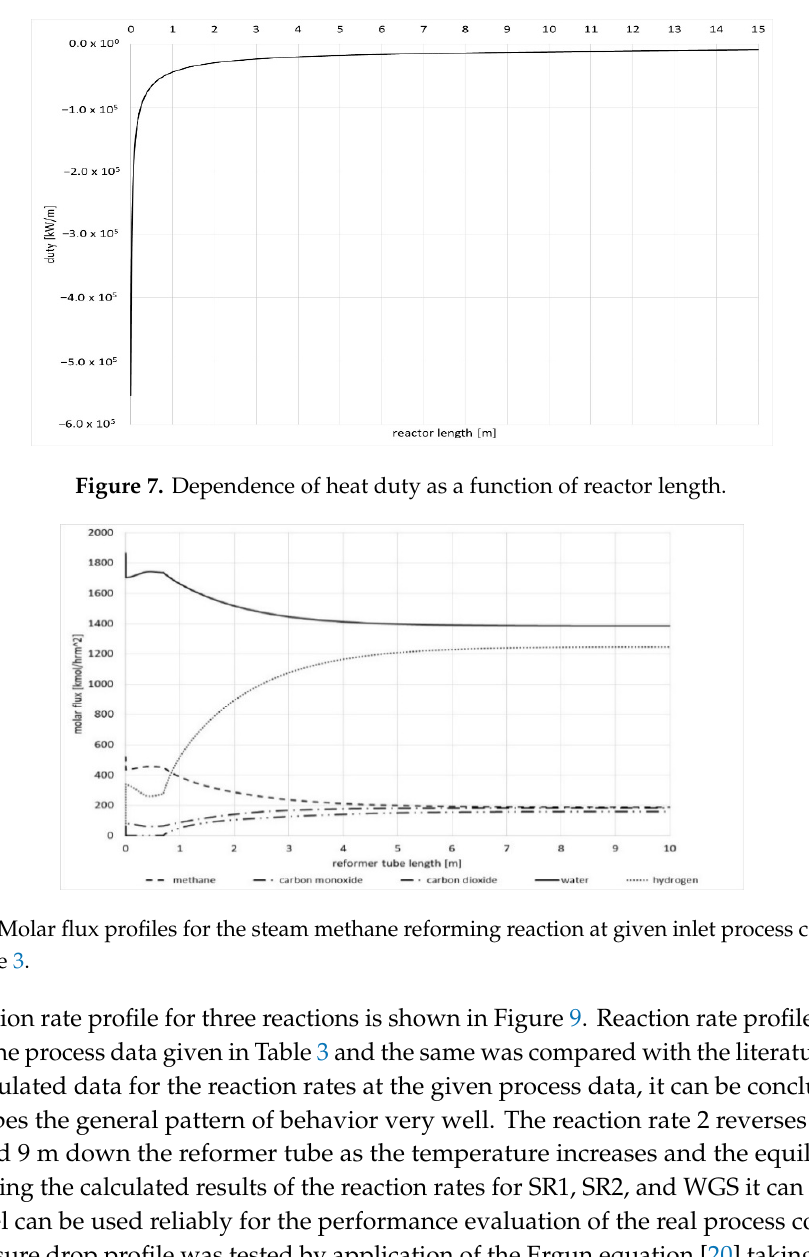
Figure 8. Molar flux profiles for the steam methane reforming reaction at given inlet process conditions from Table 3.